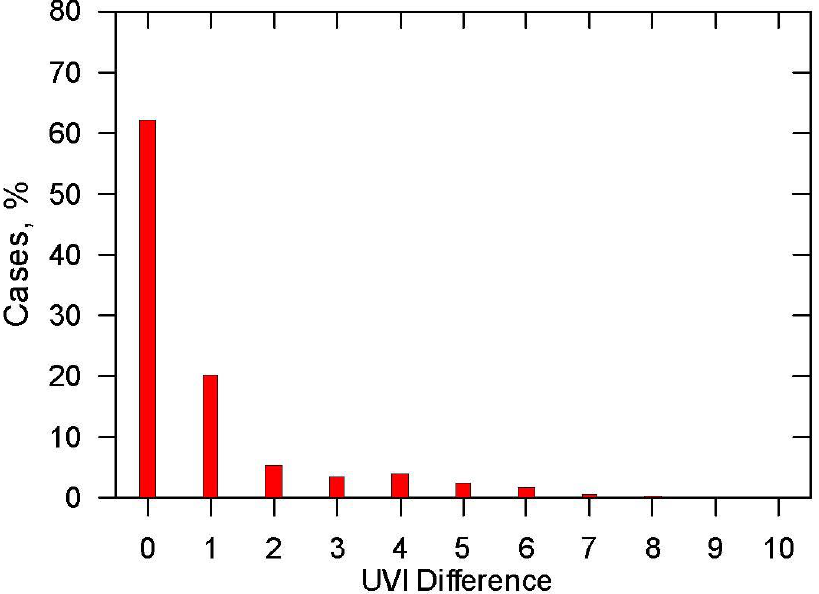
Figure 4. Ultraviolet index (UVI) index differences between values at solar noon and the maximum daily UVI (integer UVI units) in Valladolid, Spain, for the period 2013–2019. We, therefore, observe that the UV index at solar noon disagreed with the maximum daily value by one or less in 82.4% of the cases studied in Valladolid, Spain. These results are comparable to those obtained by [26] who analyzed 10 years of UV measurements at 16 of the Spanish UVB Radiometric Network stations. Results show that the percentage of coincidence is lower for stations at which cloudiness is more variable. Authors [26] have found that the percentage of cases for which the difference between the two criteria was zero or one UVI unit varied between 89%, in A Coruña, Spain, and 95%, in El Arenosillo, Huelva, Spain where the average value is 92%. The result is higher in the south of Spain.